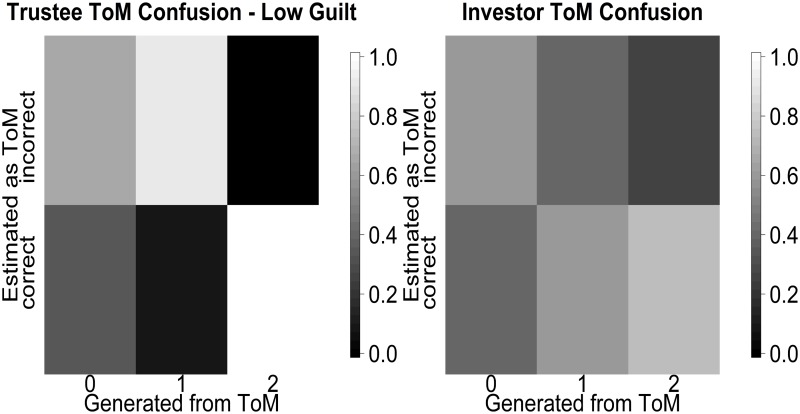
Classification probability reported in [24].In analogy to Fig 18 we depict the generated vs estimated values in a matrix scheme.